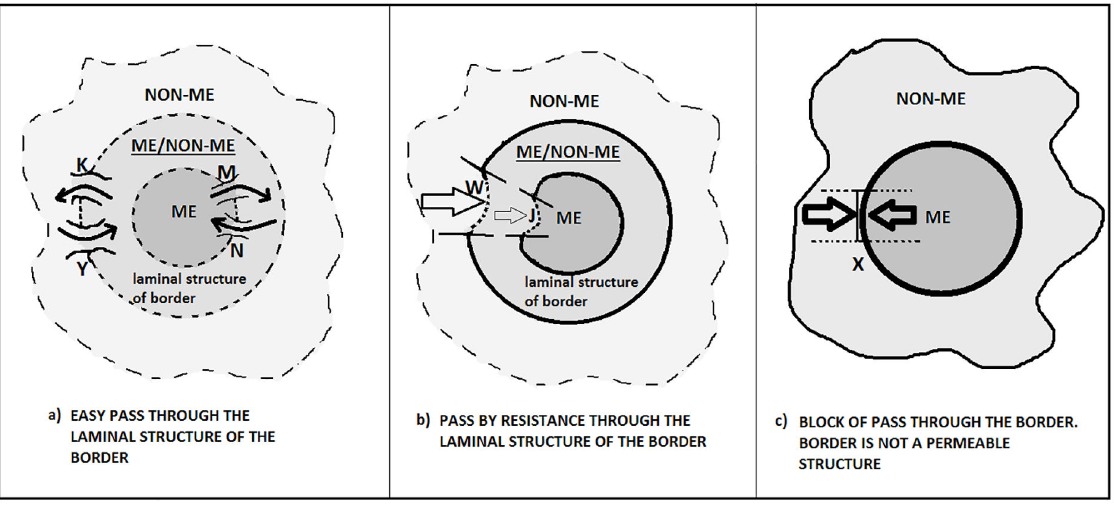
Figure 3. Dynamics of the liminal structure of the